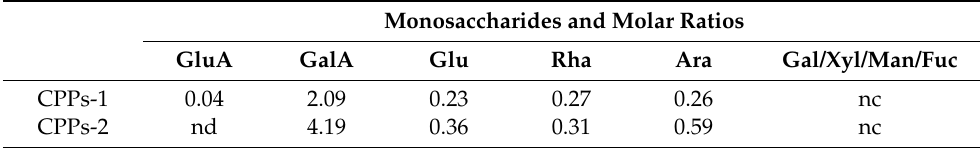
Table 6. Monosaccharide composition and their molar ratio of CPPs-1 and